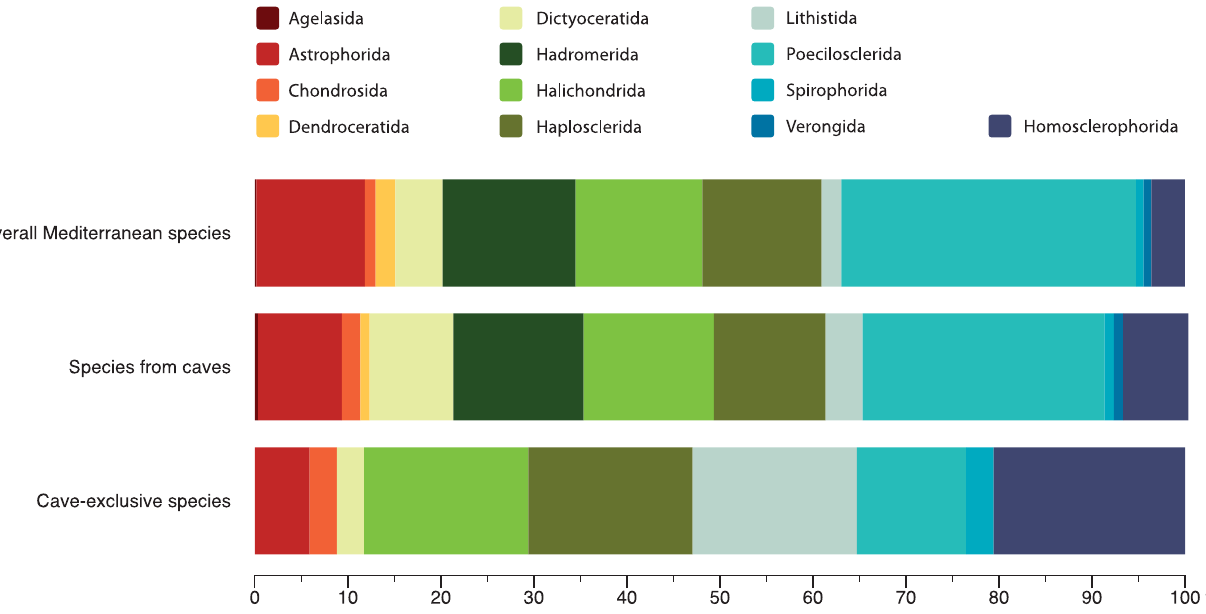
Figure 3. Order composition of cave and overall Mediterranean Demospongiae and Homoscleromorpha.